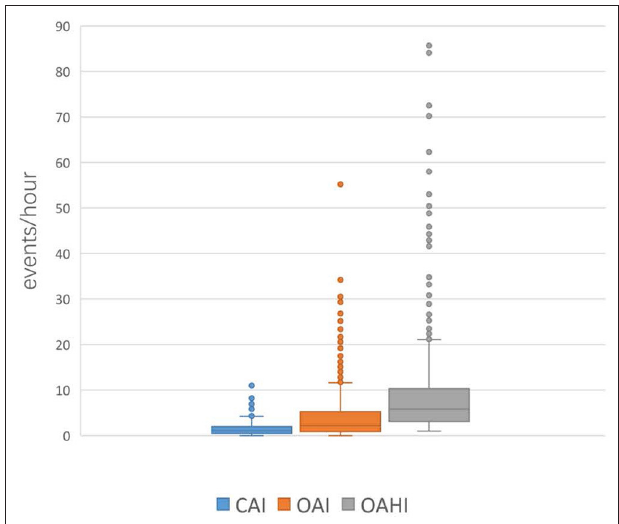
FIGURE 2 | Distribution of the CAI, OAI, and OAHI in all children with OSA.